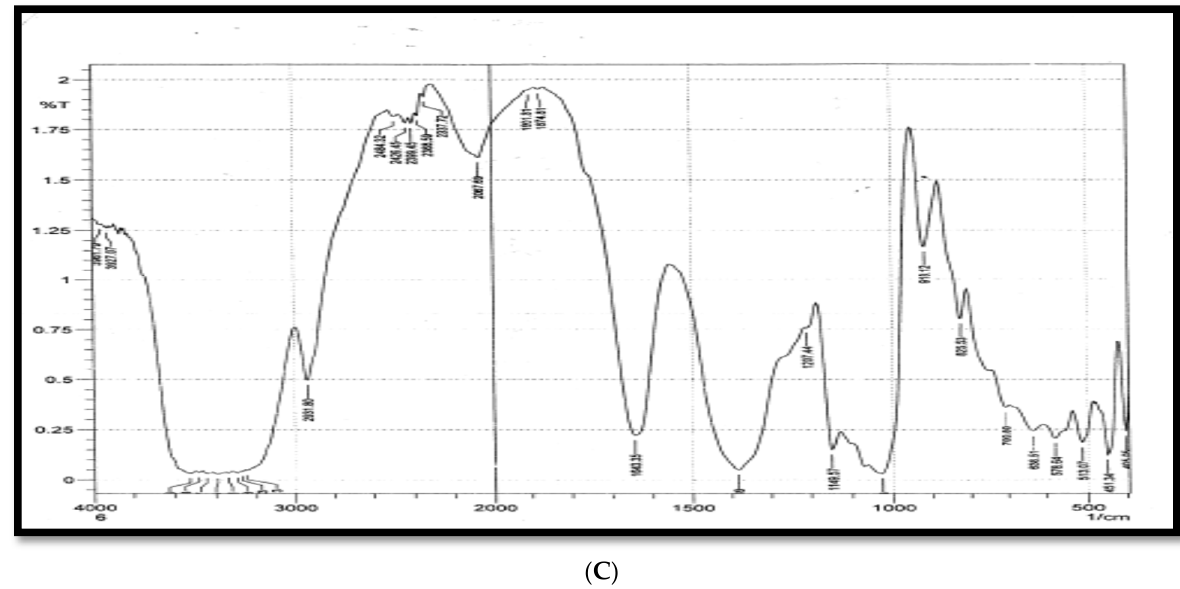
Figure 5. ( A ) UV/Vis spectrum. ( B ) The FTIR spectrum of the compound. ( C ) FTIR spectrum of fraction 6.